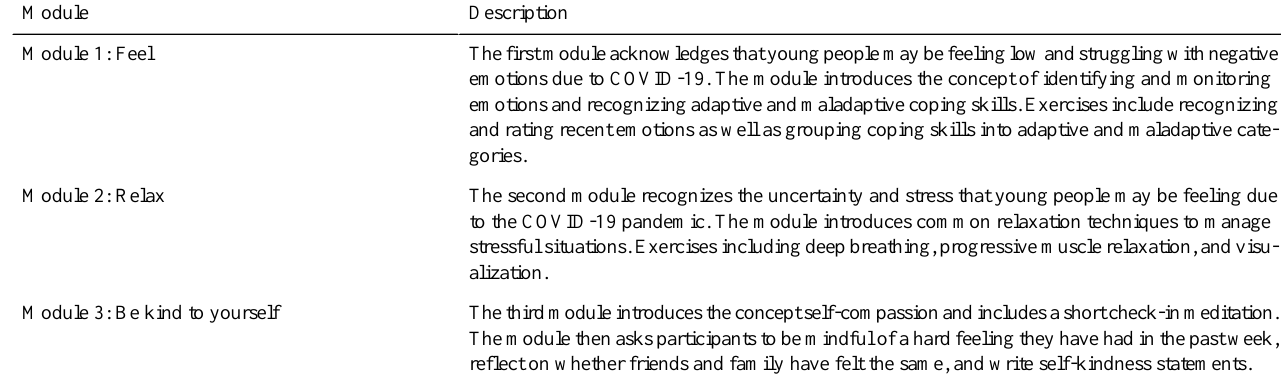
Table 1. The seven modules included in the Whitu: 7 Ways in 7 Days app. DescriptionModule